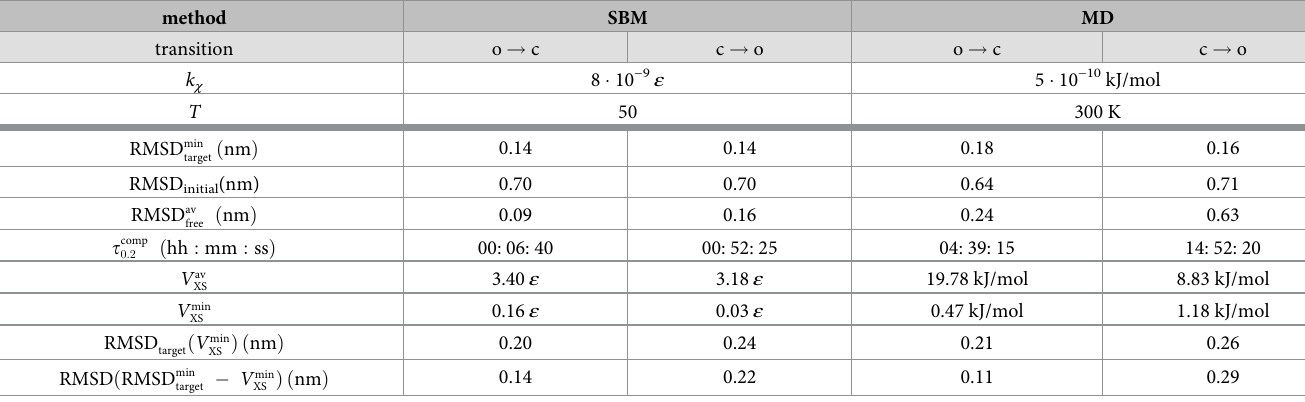
Open-to-closed and closed-to-open transition are referred to as o ! c and c ! o, respectively. Minimum target RMSD ( RMSD min